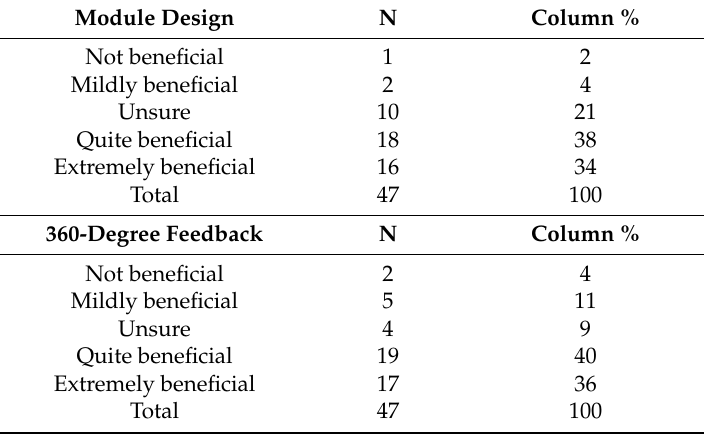
Table 2. Evaluation of course features by women who attended the Career Progression for Women (CPW)